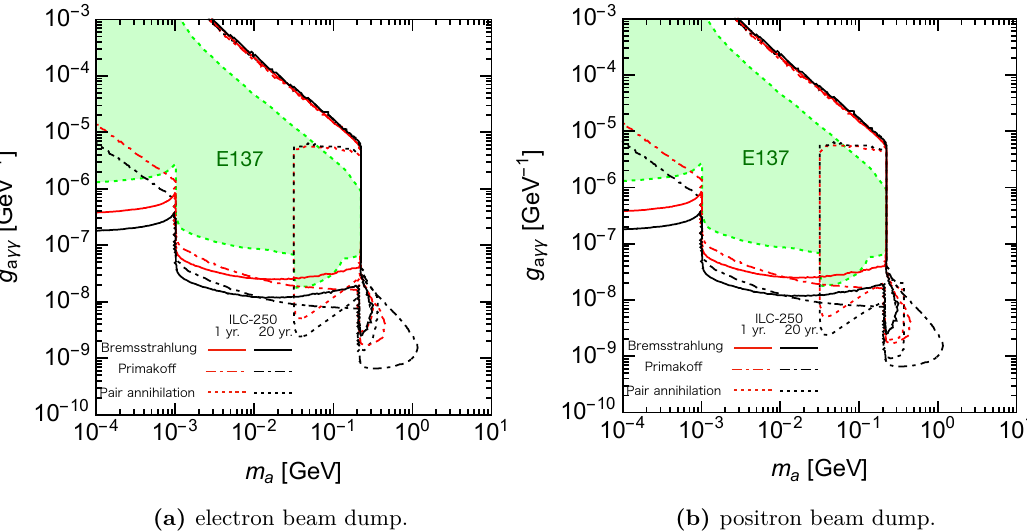
Figure 7. The same plot as figure 6 but in the ( m a , g aγγ )